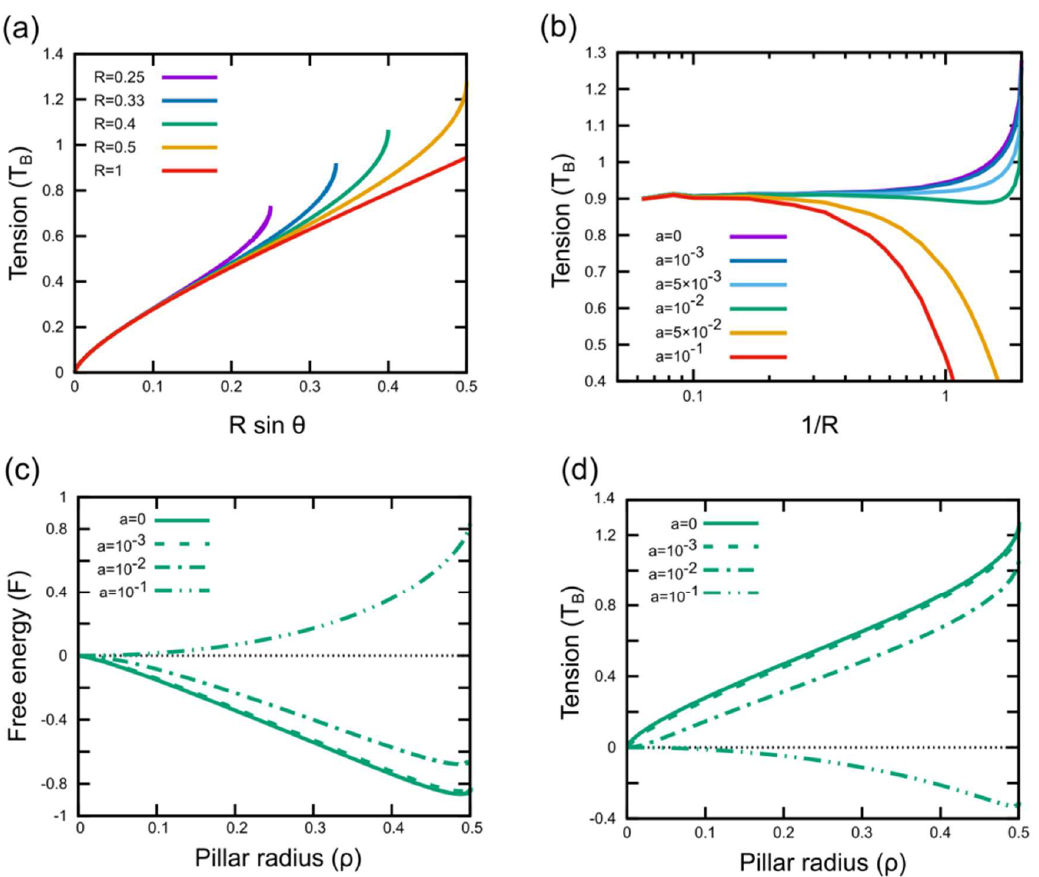
Figure 4. Dependency of tension in the suspended region of the cell envelope and the free energy on surface topography and adhesion. ( a ) Plot shows the monotonic increase of tension in the suspended region with an increase in the wetting angle θ. Different lines correspond to various radius values of curvatures of the pillar cap for a cell envelope without any bending rigidity. ( b ) Plot shows how tension in the suspended region changes with the pillar cap curvature. Different lines correspond to various levels of bending rigidity of the cell envelope. ( c–d ) Plots show how free energy ( c ) and tension in the suspended region ( d ) change with the pillar radius. Different line trends correspond to different levels of bending rigidity (shown as a). The dotted line at y = 0 in ( c–d ) represents the situation when there is no change in free energy or tension, respectively, with respect to the initial configuration of the cell envelope. For a sufficiently high bending rigidity (a = 0.1), the change in free energy is positive, indicating that the adhesion of cells to the surface is energetically unfavorable.